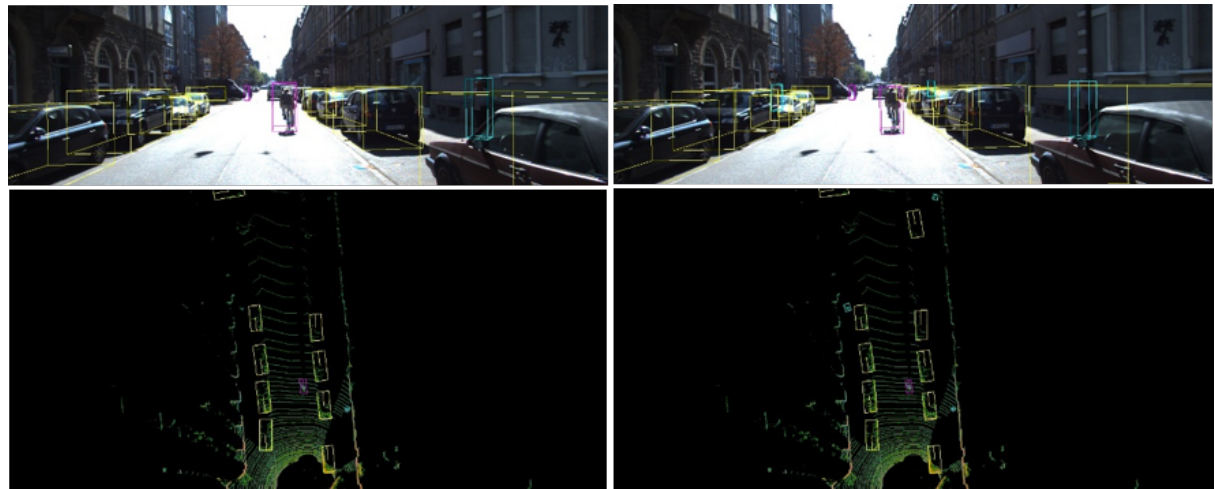
Figure 9. Example of a KITTI frame inference results for PTQ (left point cloud top view) and Optimised QAR (right image) configuration 2